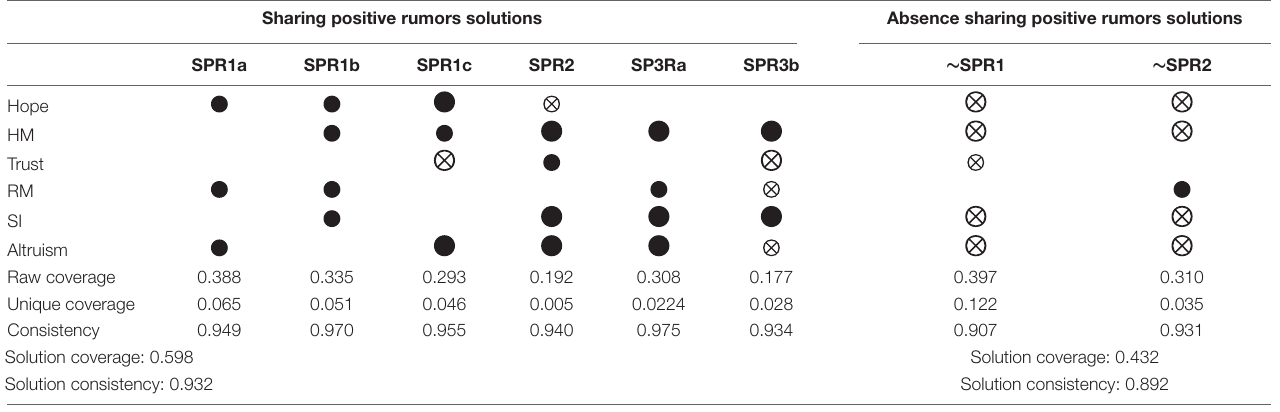
TABLE 4 | Configurations for sharing and absence sharing positive rumors.